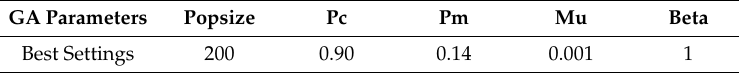
Table 7. The optimal combination values of the GA parameters.